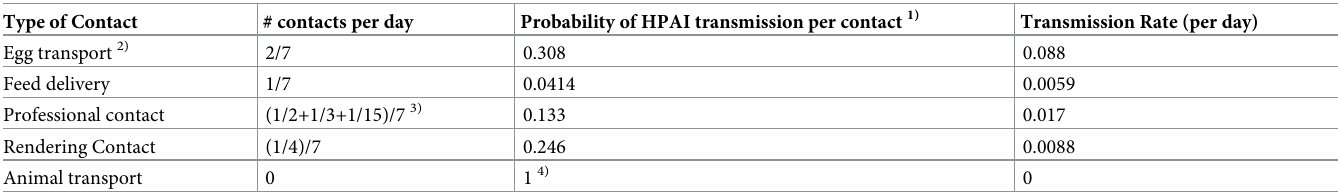
Table 1. Overview of between-farm contact types within the VPI compartment, their frequency, and the probability of HPAI transmission per contact, as estimated from the H7N7 HPAI epidemic in the Netherlands in 2003. By multiplication of these two data, the transmission rate was